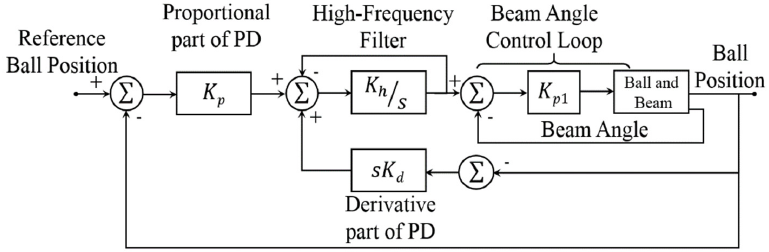
Figure 12. Alternative PD design for the ball and beam apparatus.